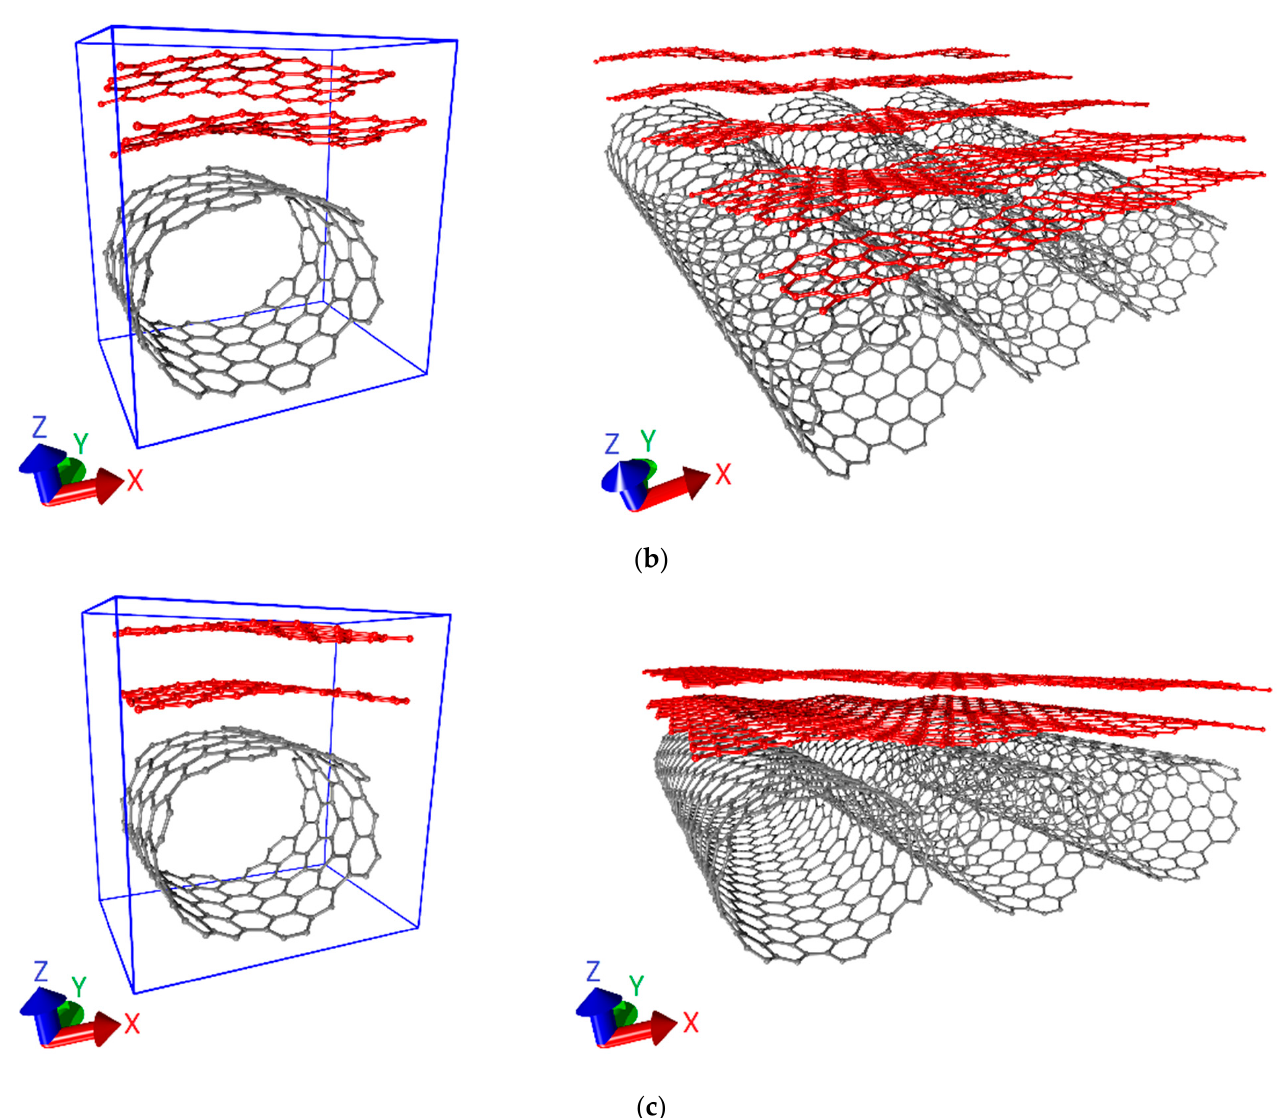
Figure 1. Supercells (left) and extended fragments (right) of composite films formed by bilayer graphene and SWCNTs (12,6): ( a ) model V1; ( b ) model V2; ( c ) model V3. The blue box represents the periodic box.